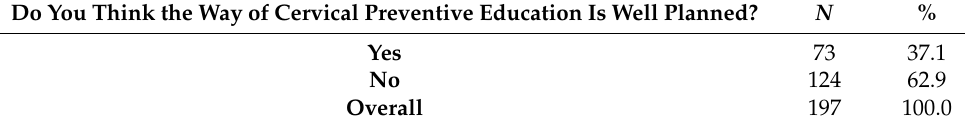
Table 10. Results of the group analysis in terms of the incidence of people who believe that the method of preventive cervical education is well planned. N % Yes 73 37.1 124 62.9 Overall 197